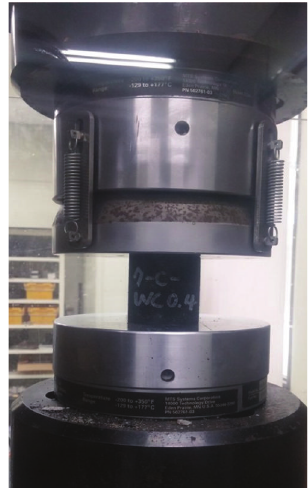
Figure 4: Test setup for evaluating the compressive strength.